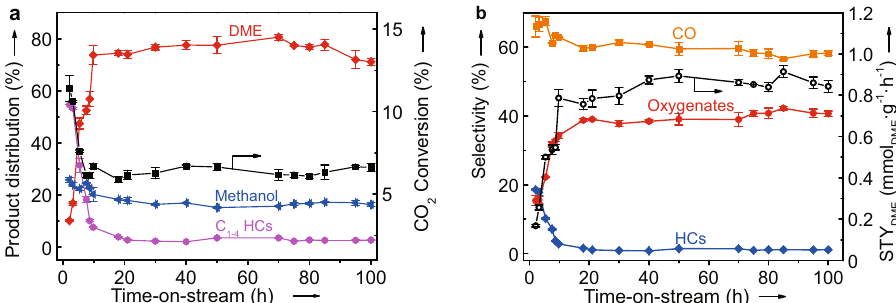
Fig. 4 The representative long-term stability results for the hydrogenation of CO 2 over GaN-26.6. a The CO 2 conversion and the CO-free distribution of the hydrocarbons (HCs) and oxygenates. b The selectivity of different products and space-time yield of DME (STY DME ). The error bar is for 5% relative deviation. Reaction conditions: P = 2.0 MPa, T = 360 °C, H 2 /CO 2 = 2, and gas hourly space velocity = 3000 mL g − 1 h − 1 .